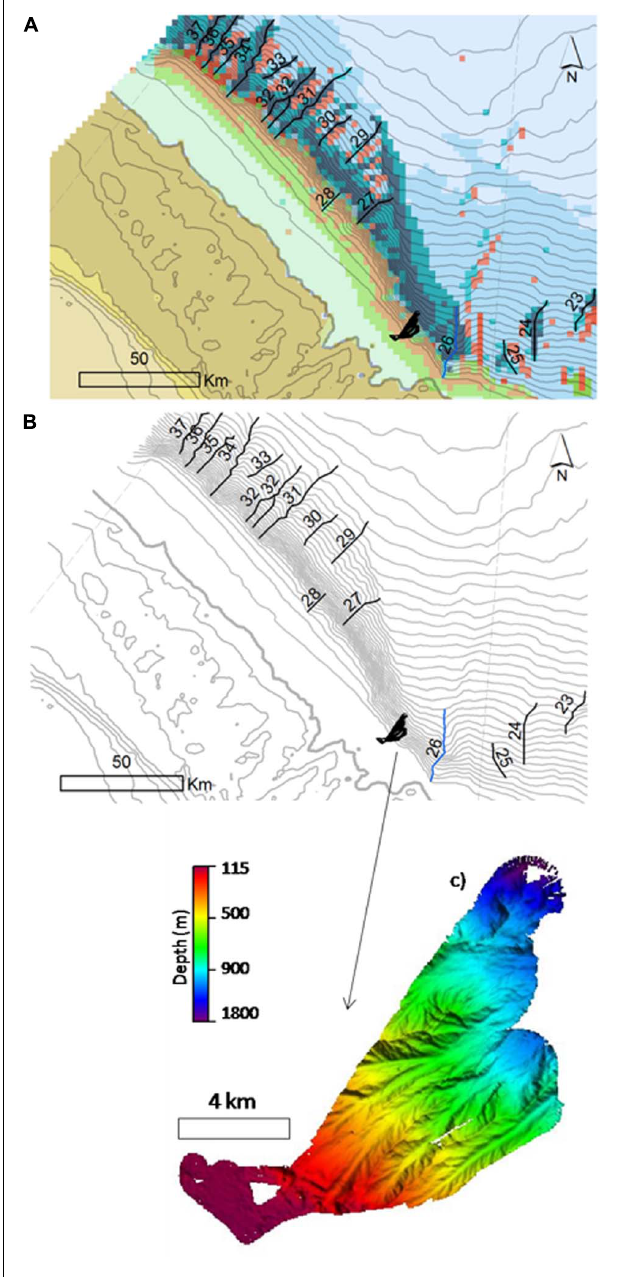
FIGURE 7 | Continental slope depressions in sector S3. Mapping procedures followed the combined methods of delineation by BTM seabed classes thalweg 1 and 2 (A) , and the DTM with isobaths spacing each 100-m water depth interval (B) . Depression types are discriminated by colors: (1) depressions not classified as canyons and confined at the continental shelf (black lines), (2) canyons that are confined to the continental slope (blue lines), and (3) canyons that incise the continental shelf (red lines). Vertical exaggeration